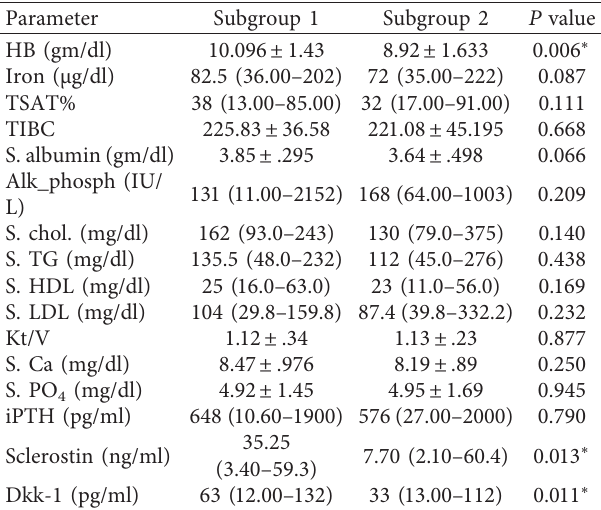
Table 3: Comparative analysis of some laboratory data among the studied two